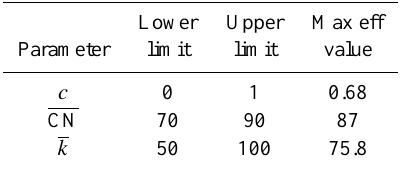
Table 6. Ranges of parameters considered for the calibration.